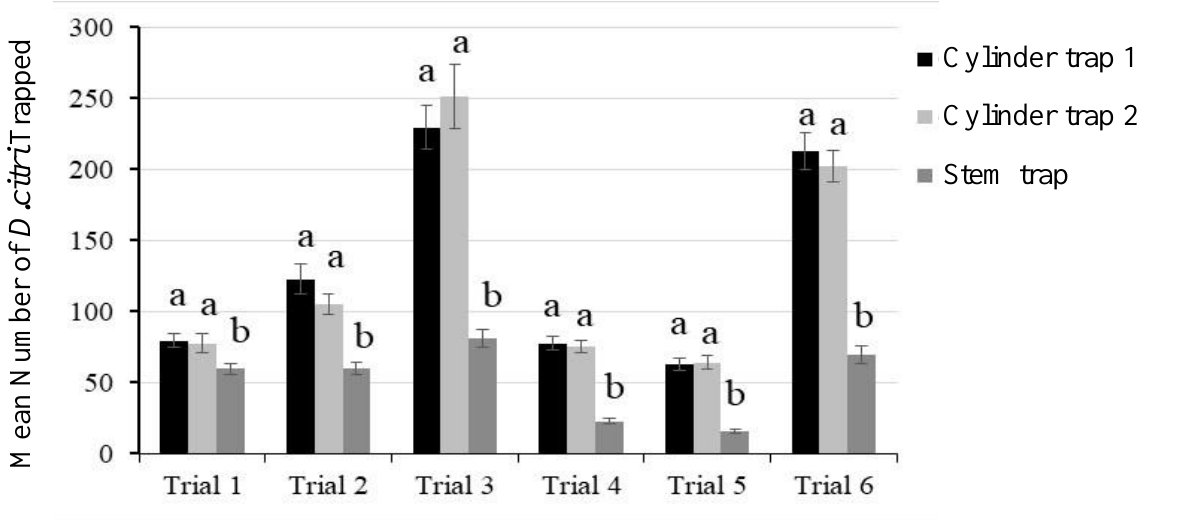
Figure 6. Trap evaluations in field cages in Pomona, California. Six trials were conducted between May 2018 and April 2019, and each trial was conducted for four weeks. A total of 48 traps (16 of each type) were used in 2 field cages per trial. The mean number of ACPs captured per trap, per location for the four-week period is shown. The standard error indicated as bars. The use of different letters indicates significant differences in the ACP capture rate.